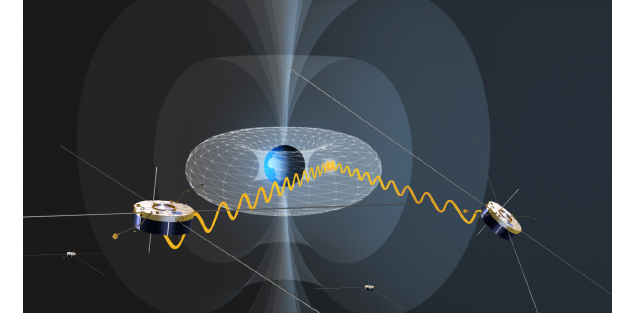
Figure 10. The Cluster tilt campaign. The Cluster spacecraft C3 and C4, in the foreground, were used as a single observatory for the study. The C3 spacecraft (right) is shown in the special “tilt” config- uration that was used for the observations for a period of 1 month. The 45 ◦ tilt allowed for detection of the signal in 3-D, and showed much better results to the more typical triangulation